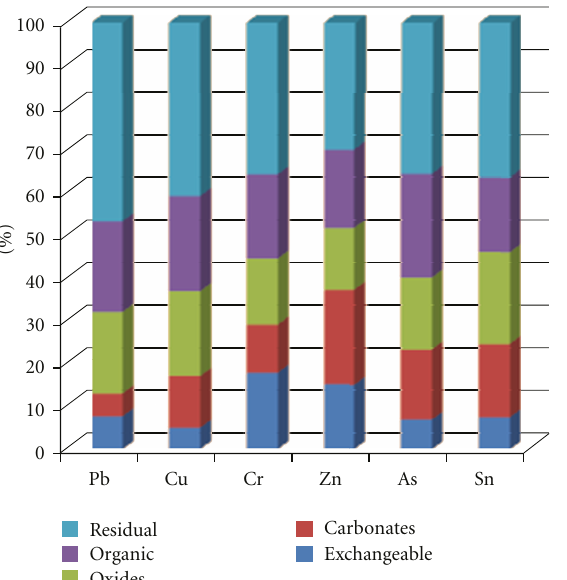
Figure 3: Potential mobility of